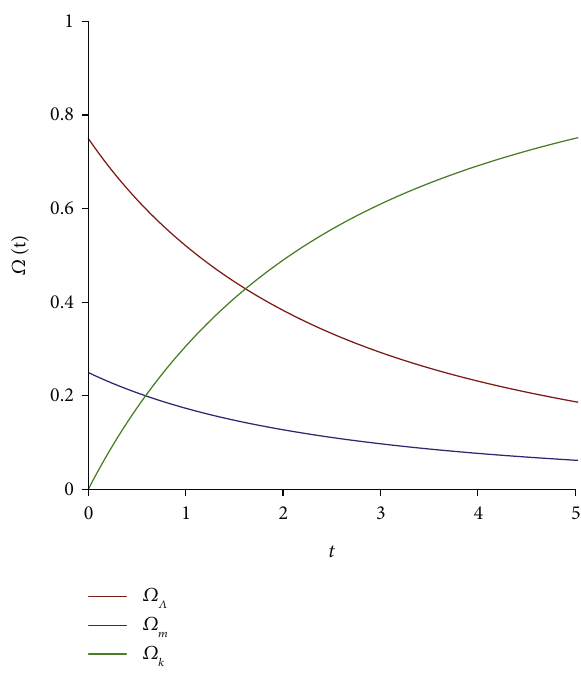
6: Plot of Ω ð t Þ versus t for k = − 1